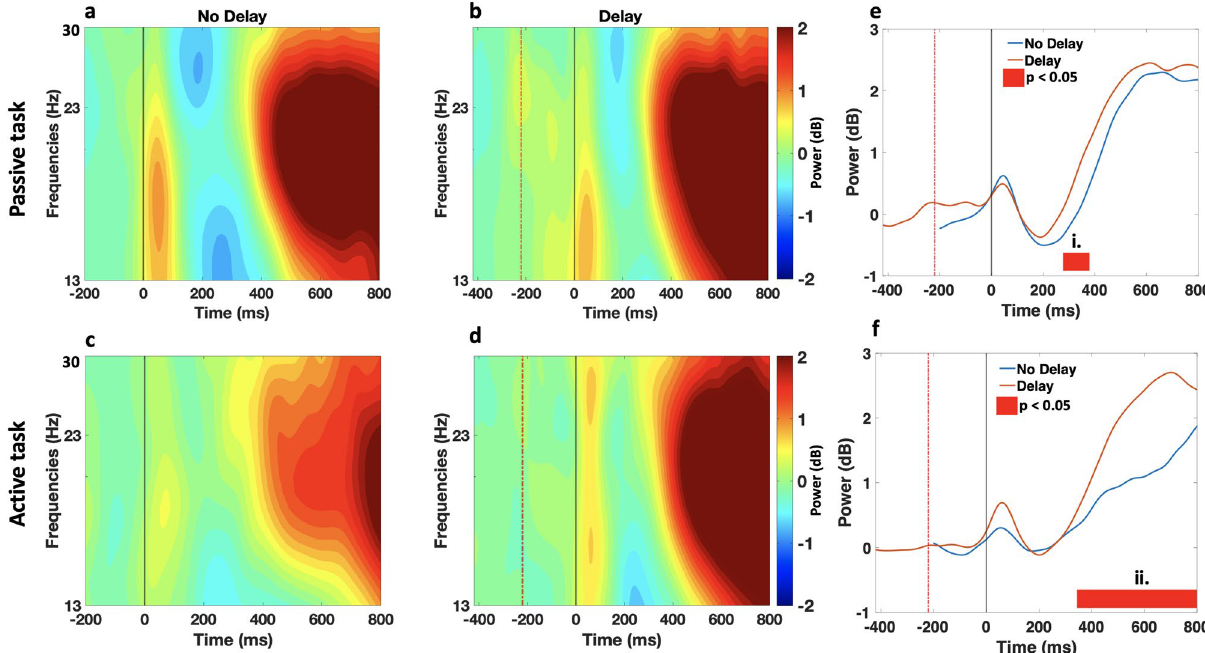
Figure 4. Contralateral sensorimotor ROI time-frequency data. ( a – d ) ERSP dynamics of the EEG data in the sensorimotor ROI averaged over trials and subjects per condition and task. Time 0 ms corresponds to the haptic collision event denoted with a grey (solid) line, while the red (dashed) line denotes the event of the visual collision in the delayed condition. A beta rebound is observed under all conditions starting around 200 ms from the haptic collision onset. ( e , f ) Time-course of beta power (13–30 Hz) under the no delay (blue) and delay (orange) conditions time-locked to the haptic collision. Both waveforms are plotted starting with their corresponding baseline (200 ms before the visual collision). Significant time window is (i. 280–380 ms; p < 0.05, randomization test, FDR corrected) for the passive task and (ii. 360–800 ms; p < 0.05] , randomization test, FDR corrected) for the active